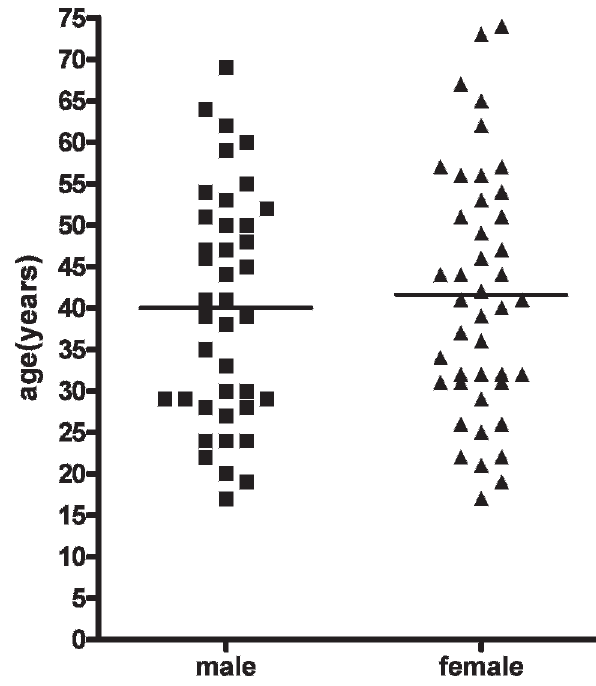
Figure 1 - Age distribution according to gender in 83 cases of hyperparathyroidism/multiple endocrine neoplasia type